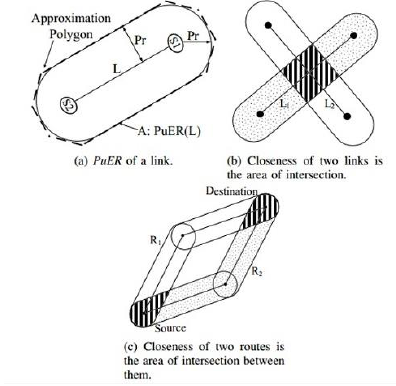
Figure 3. Routes closeness metric definition